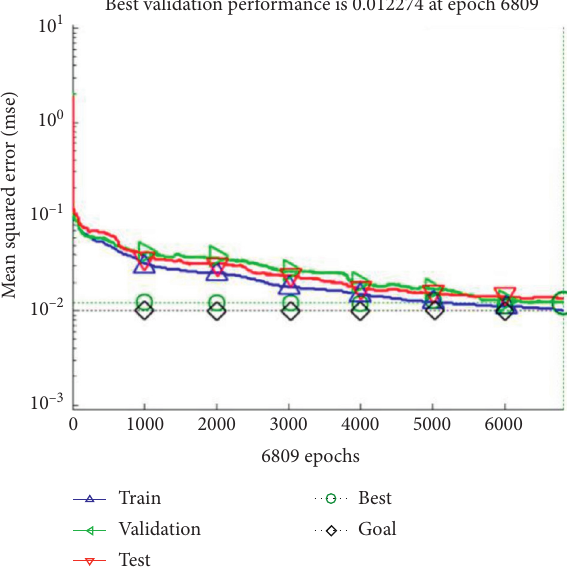
Figure 5: The training error curve of CF